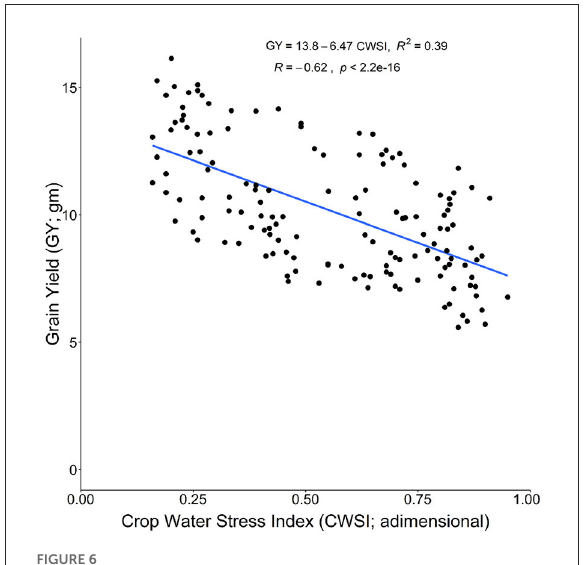
FIGURE6 Relationship between GY across the cultivars as the dependent variable with crop water stress index as an independent variable under DS, HS, and DHS